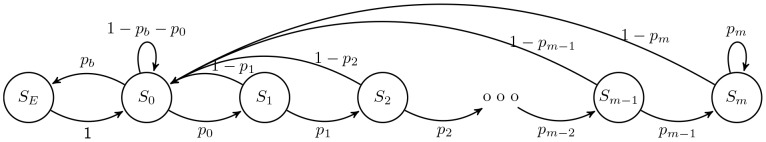
The state transition diagram of EPSS.